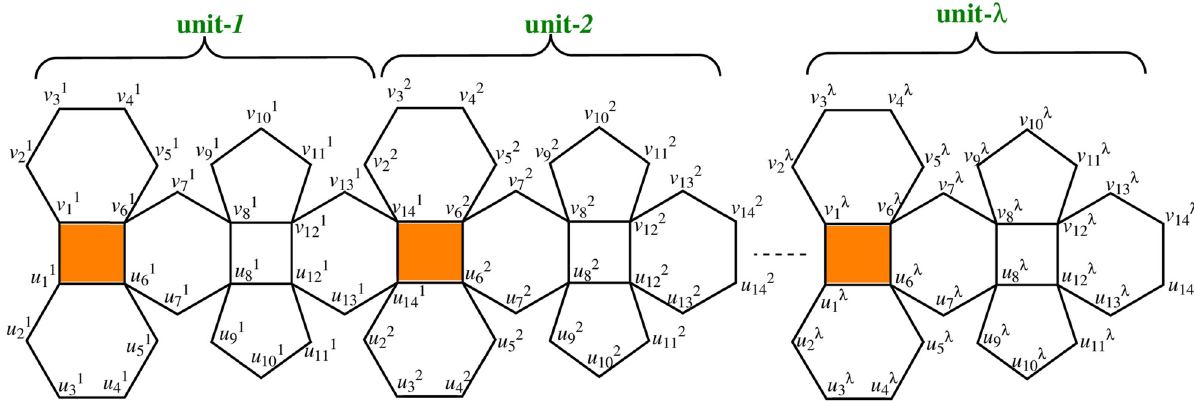
Figure 4: Structure of polyhedron generalized sheet of ∗ C 28